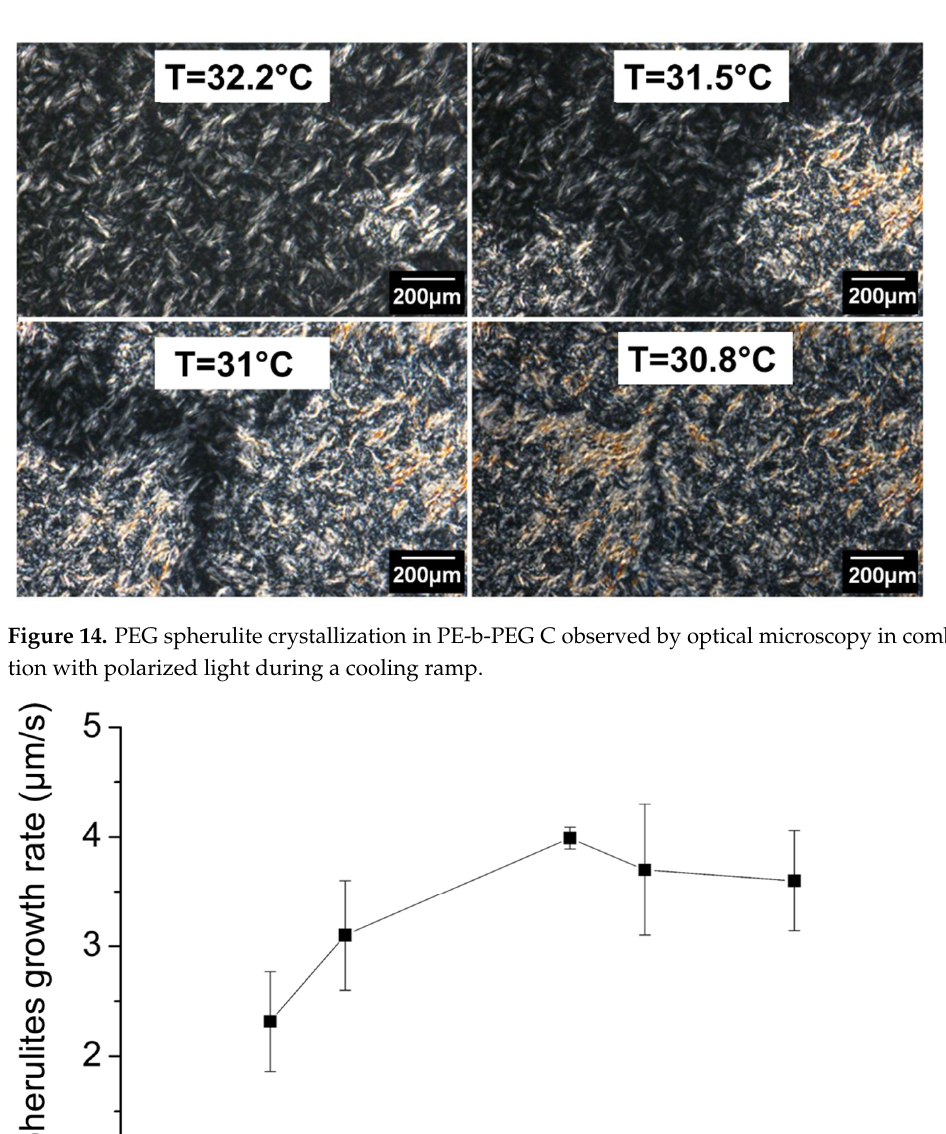
Table 4. Comparison of the melting and the crystallization temperatures of PE and PEG blocks for PE-b-PEG C obtained by optical microscopy and DSC.